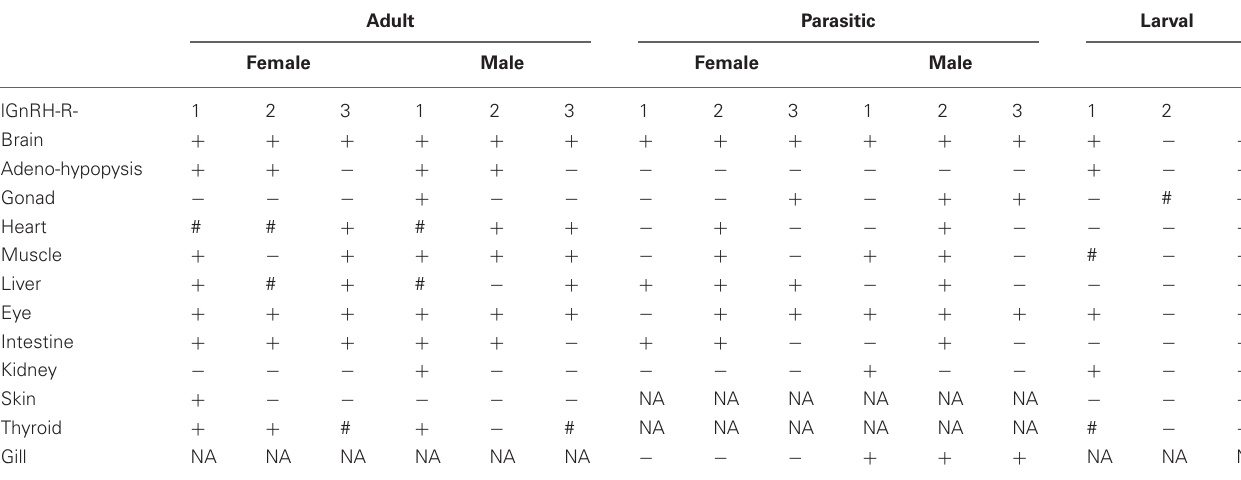
Table 2 | Results of receptor mRNA expression in various sea lamprey tissues by reverse transcriptase-PCR. Adult Parasitic Larval Female Male Female